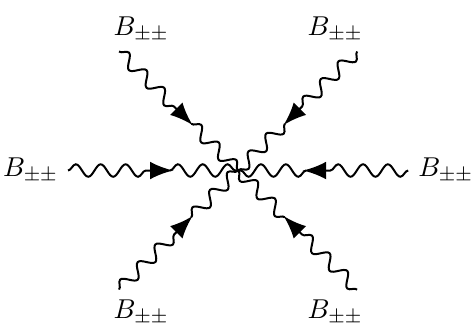
Figure 2 . Diagrammatic expression of the local term for a six-particle amplitude. In the example where all external particles are B ab , this local term vanishes, and the exchange diagrams are the only contribution to the total